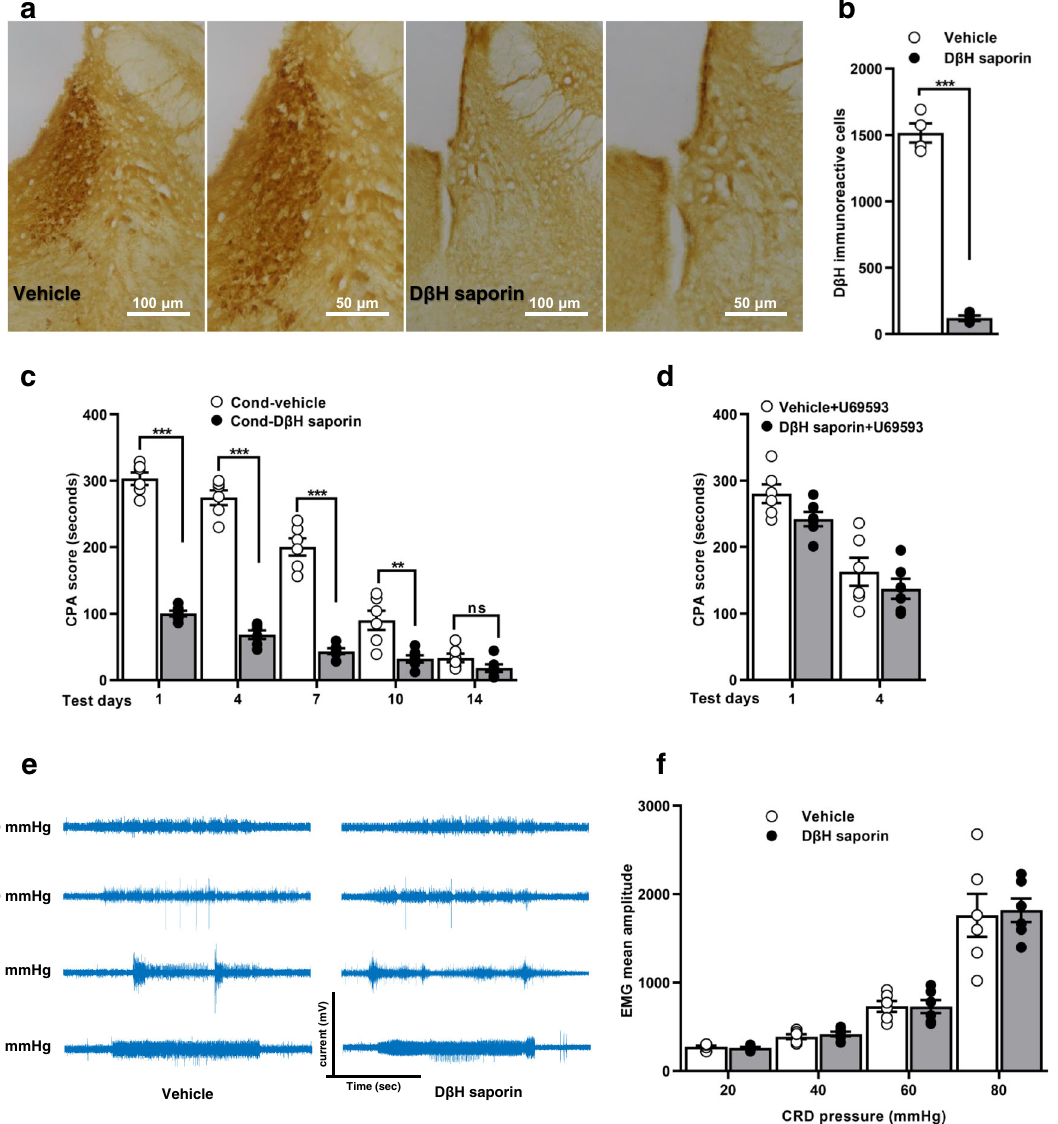
Fig. 1 Immunotoxic ablation of locus coeruleus noradrenergic neurons impairs visceral noxious aversive memory but had no effect on acute visceral pain behaviours. a Representative images showing cell population of LC noradrenergic neurons in vehicle and D β H saporin injected rats. Scale bar: 100, 50 µ m. b Quanti fi cation of D β H immunoreactivity ( n = 4/group with 3 sections from each rat; t 6 = 18.65, *** p < 0.0001, unpaired t-test). c CPA score in the vehicle and D β H saporin rats on test days ( n = 6/group; *** p < 0.0001, ** p < 0.001, ns p = 0.7149, two-way ANOVA with Bonferroni test). d CPA score to U-69593, induced CPA in vehicle and D β H saporin rats ( n = 6/group; p = 0.6881, two-way ANOVA). e Representative visceromotor response